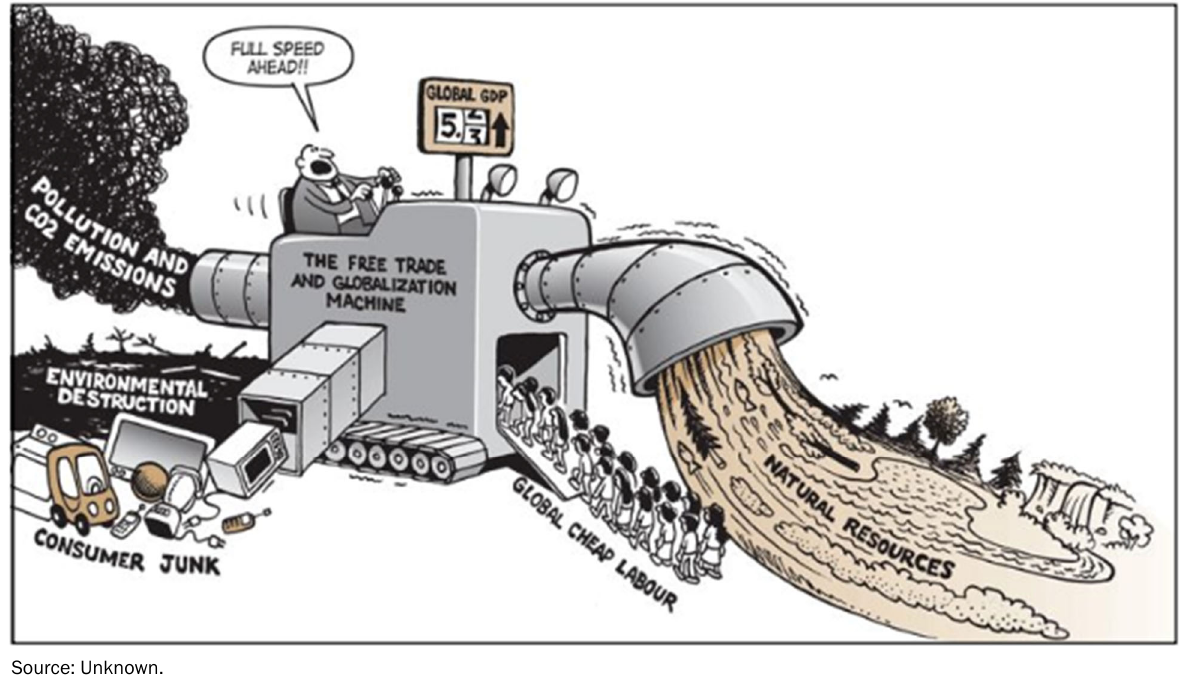
Figure 1. Full Speed